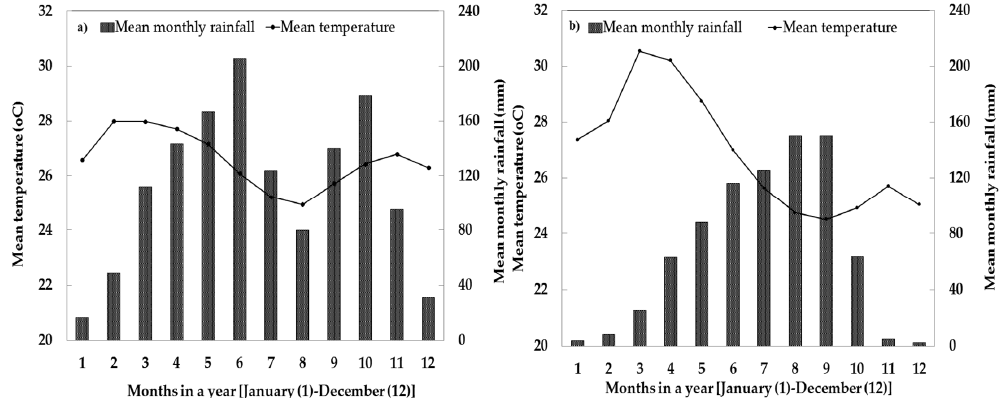
Figure 5. Mean monthly rainfall (1983–2012) and mean temperature (1983–2012) in ( a ) Deciduous forest and ( b ) Guinea savannah agroecological zone of Ghana.